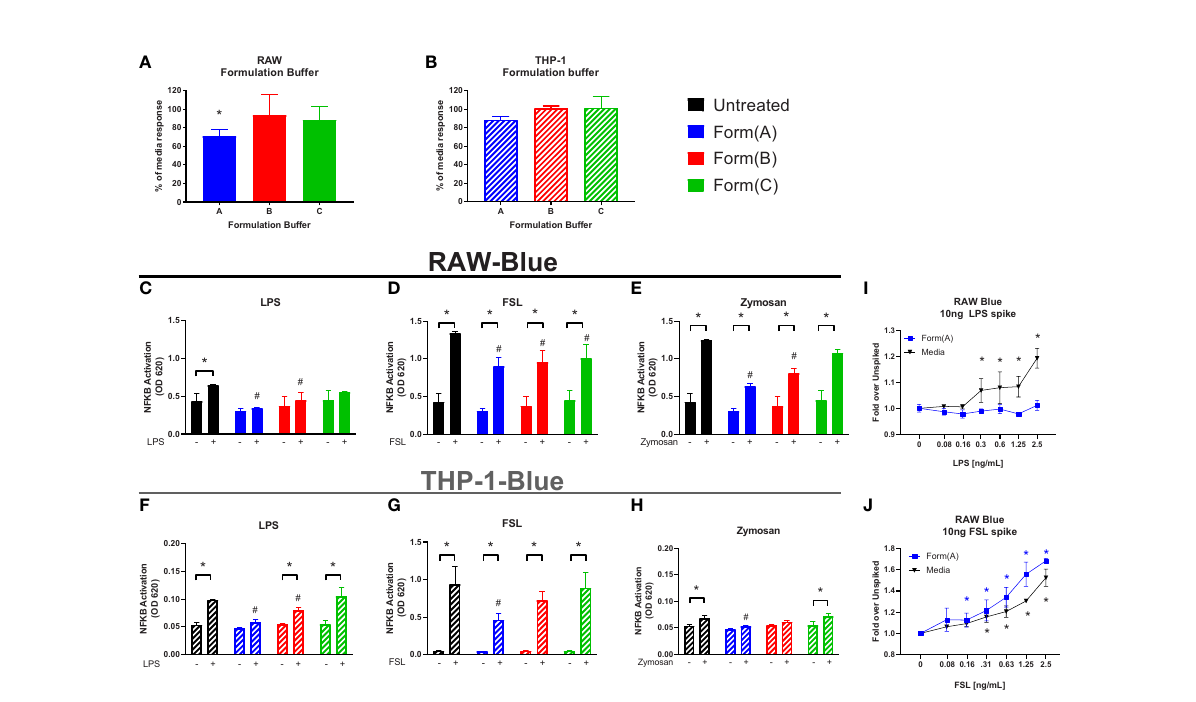
FIGURE 5 Impact of drug formulations on IIRMI detection by RAW-Blue and THP1 cells. RAW- and THP-1-Blue cells were stimulated with three model IIRMIs [(LPS (1ng), FSL (1ng), or Zymosan (1 m g)] for 24 hours in the presence of drug product formulation (25% v/v). IIRMI activation of NF- k B in RAW- and THP-1- Blue cells was measured using Quanti-blue detection media. (A – B) Impact of 25% v/v drug formulation on baseline NF- k B activation in RAW- and THP- 1-Blue cells. (C – E) RAW-Blue cells stimulated with IIRMIs for 24 hours in the presence of 25% v/v formulation. (F – H) THP-1-Blue cells stimulated with IIRMIs for 24 hours in the presence of 25% v/v formulation. (I, J) RAW-Blue cells were incubated for 24 hours with LPS or FSL in presence of 25% v/v formulation A or media alone. Results are shown relative to IIRMI stimulation in media alone (no formulation) treated cells. Results are representative of at least 3 independent experiments. Cells were treated in triplicate and results are presented as the mean ± SD. * or # p <0.05 and **p < 0.01. * indicates statistical difference between spiked and unspiked cells in the corresponding formulation; # indicates statistical difference to the level of NF- k B activation by the corresponding stimuli in the absence offormulation (black bar,